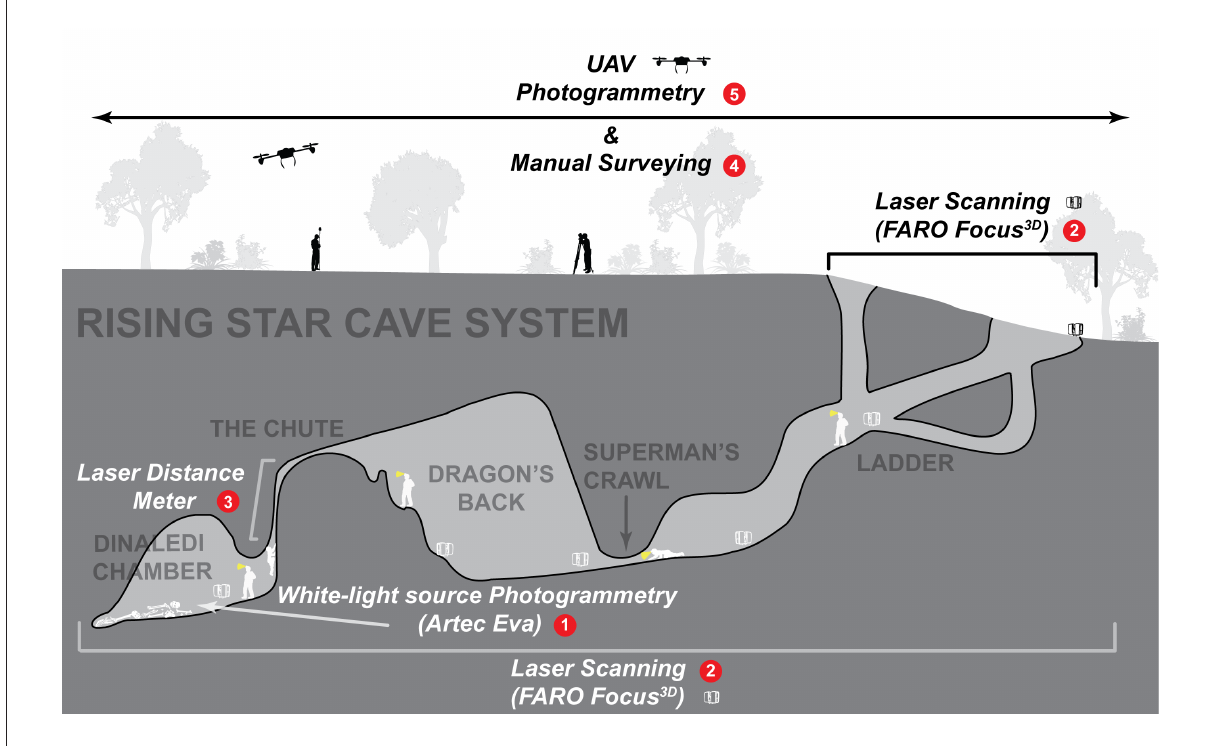
Graphic representation of the data collection techniques and specific locations in which they were employed to acquire high-resolution data at the Rising Star